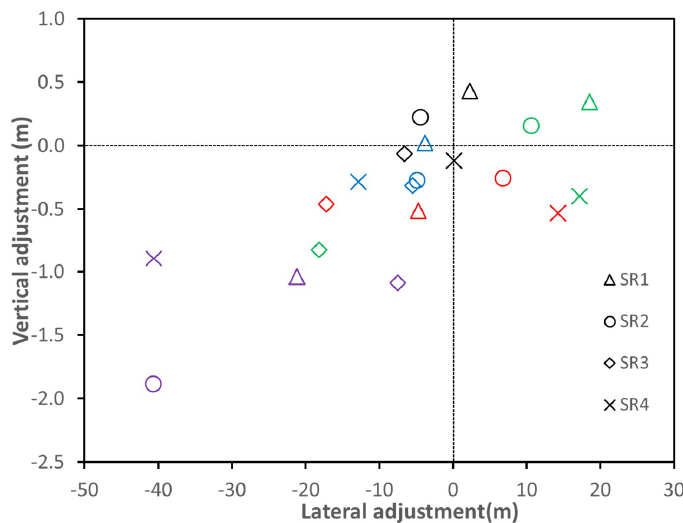
Figure 11. Relationship between change in riverbed elevation and change in bankfull width. (Red means phase I; purple means phase II; green means phase III; blue means phase IV; black means phase V).